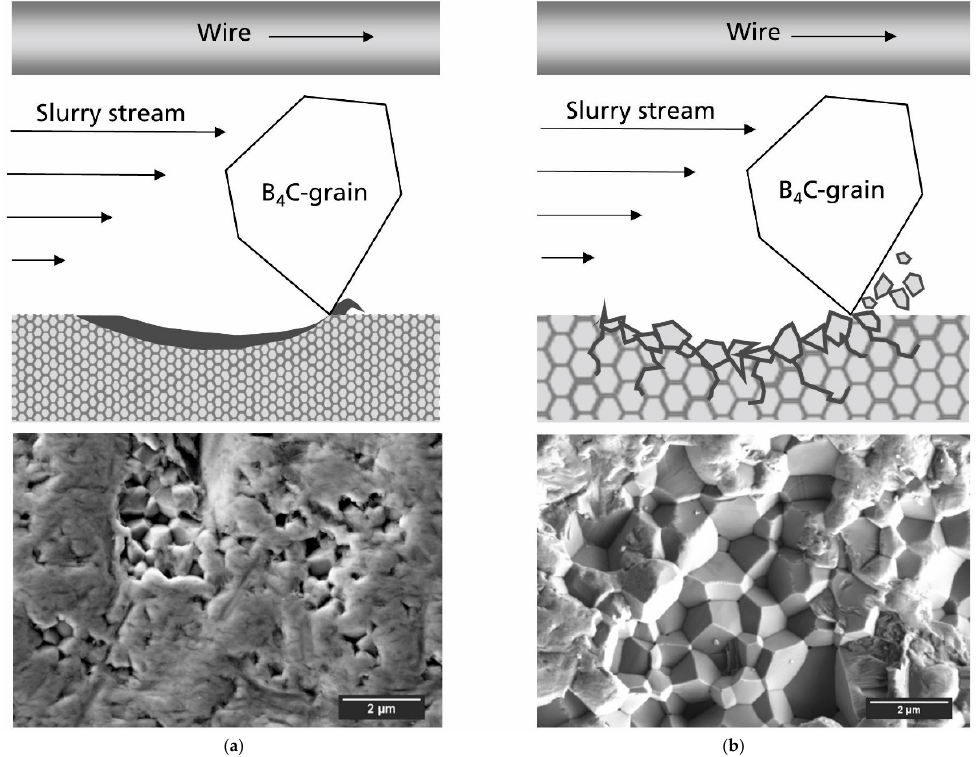
Figure 11. Cutting mechanisms in the multi-wire slurry process for Al 2 O 3 -ceramics; ( a ) deformation-controlled material removal (trans-granular) for fine grained Al 2 O 3 ; ( b ) fracture-controlled material removal (inter-granular) for coarse grained Al 2 O 3 .